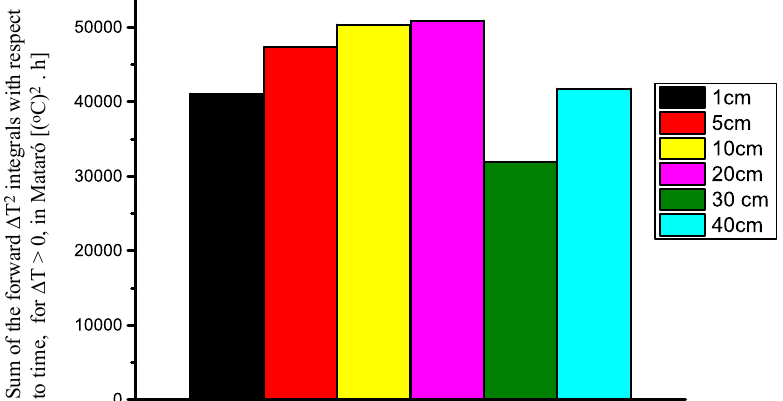
Figure 9. “Forward” integrals of ∆ T 2 with respect to time, at various depths, for 205 days, in